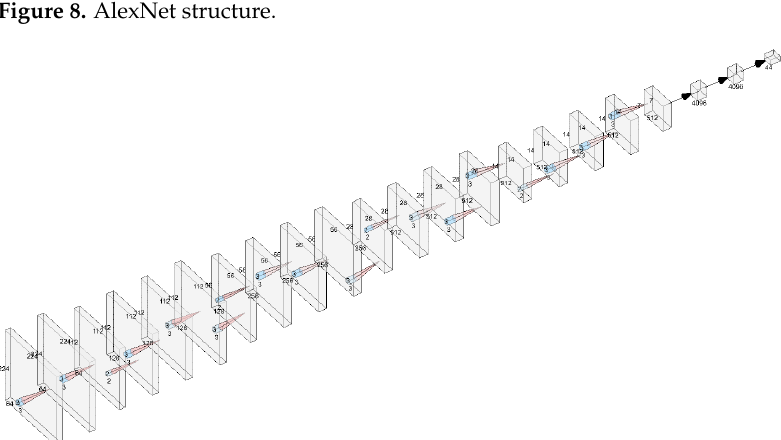
Figure 8. AlexNet structure.